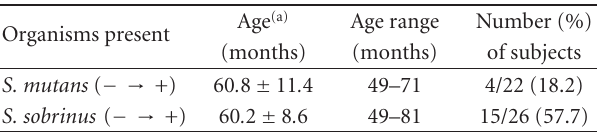
Table 2: Children and their ages with mutans streptococci acquired after 1